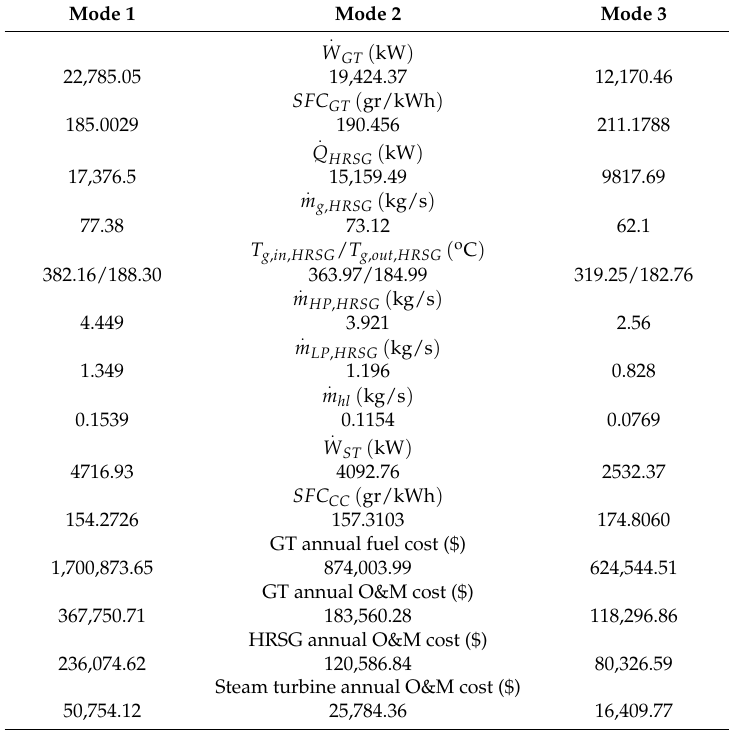
Table 11. Operational technical and economic characteristics for the system with gas turbine type (b) and fuel NG.